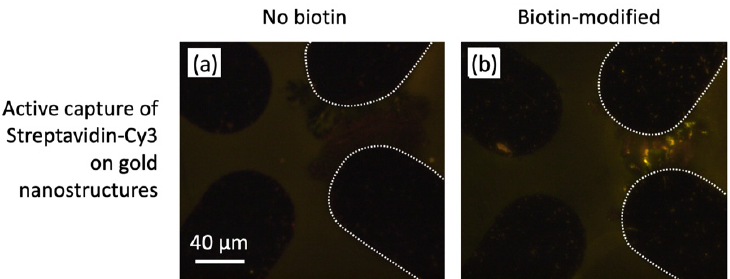
Figure 5. Fluorescence results from the biotin-streptavidin Cy3 assay. White dashed lines indicate the microelectrodes that were used to assemble the nanostructures, as well as, for active capture, the microelectrodes that were activated for analyte collection. ( a ) Active capture (analyte collected at 10 kHz, 15 V peak-to-peak, for 15 min) of streptavidin-Cy3 on a non-biotinylated gold nanostructure (nanotrees). ( b ) Active capture (analyte collected at 10 kHz, 15 V peak-to-peak, for 15 min) of streptavidin-Cy3 on a biotinylated gold nanostructure (nanotrees).